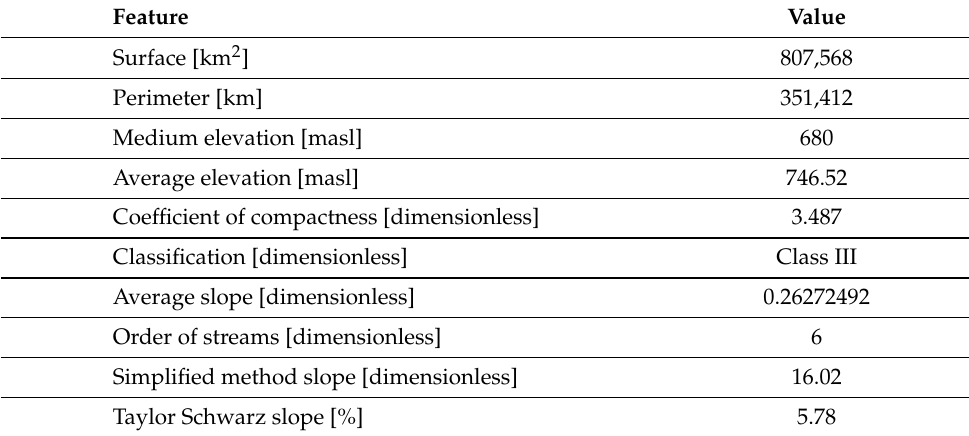
Table 1. Main features of the Gallinas